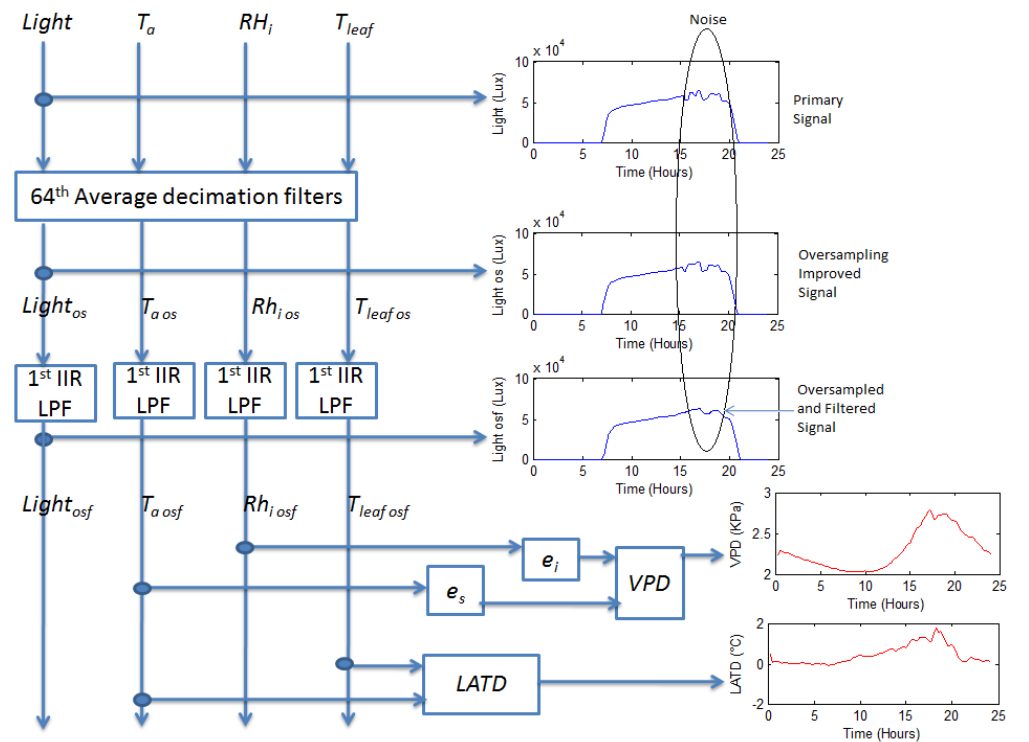
Figure 6. VPD , LATD and Light estimation signal processing